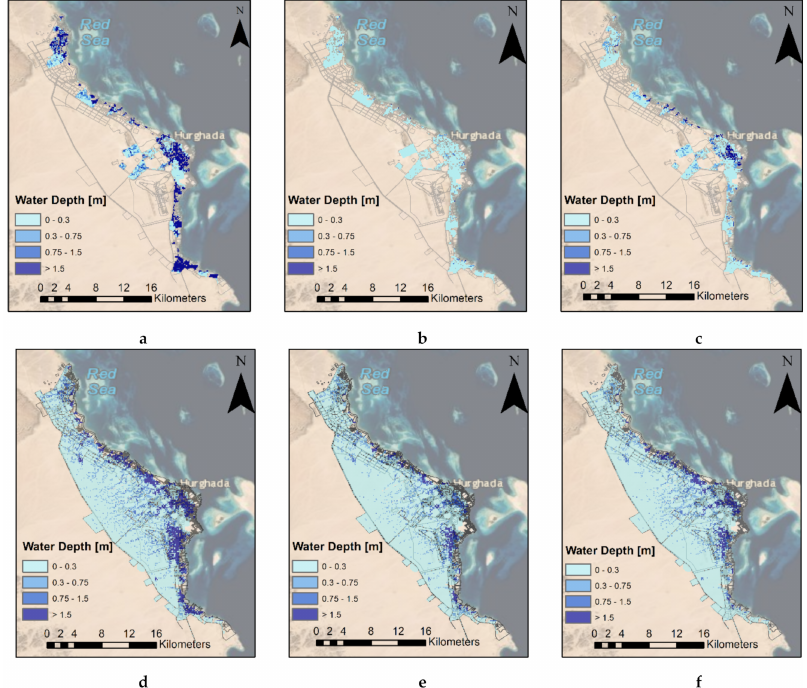
Figure 6. Flood inundation maps (RRI model) for Hurghada for the current situation ( a – c ) and